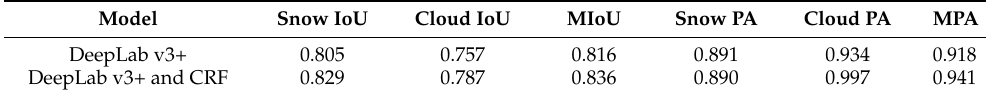
Table 6. Comparison results of different